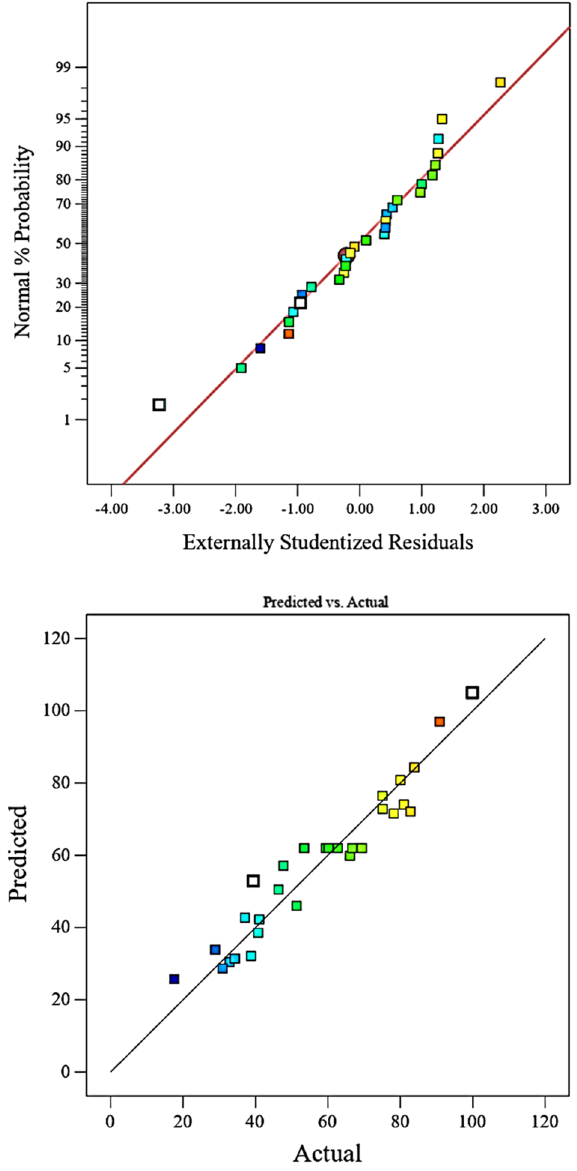
Figure 3. Normal plot and the prediction plot with the deviation from the actual data.